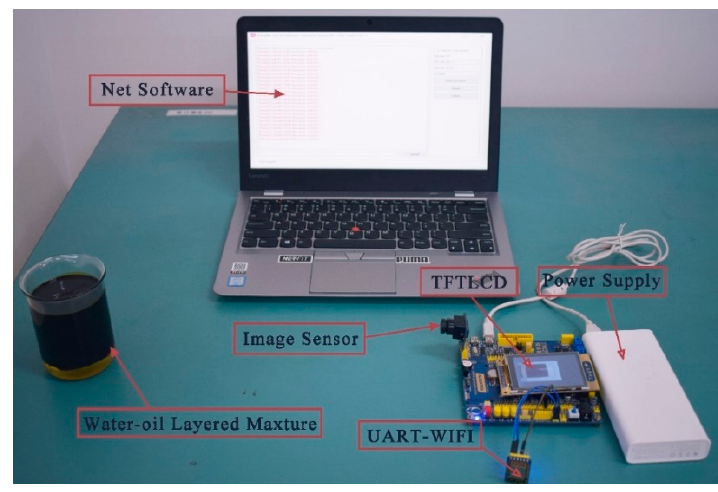
Figure 11. Physical photograph of the detection system. Sensors 2019 , 19 , x FOR PEER REVIEW